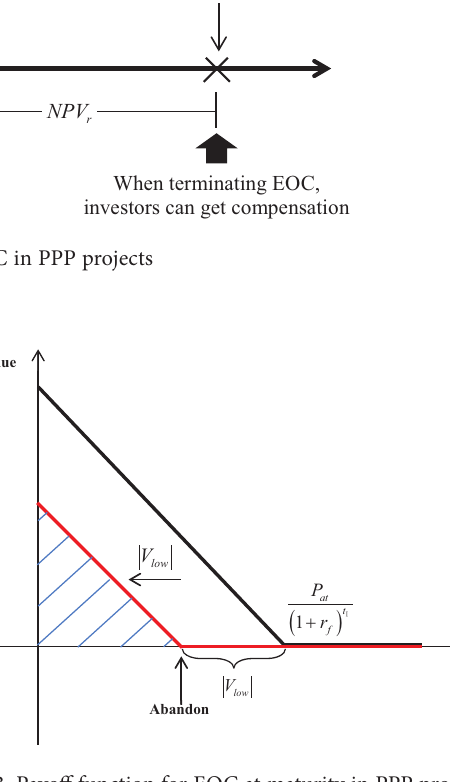
Figure 3. Payoff function for EOC at maturity in PPP